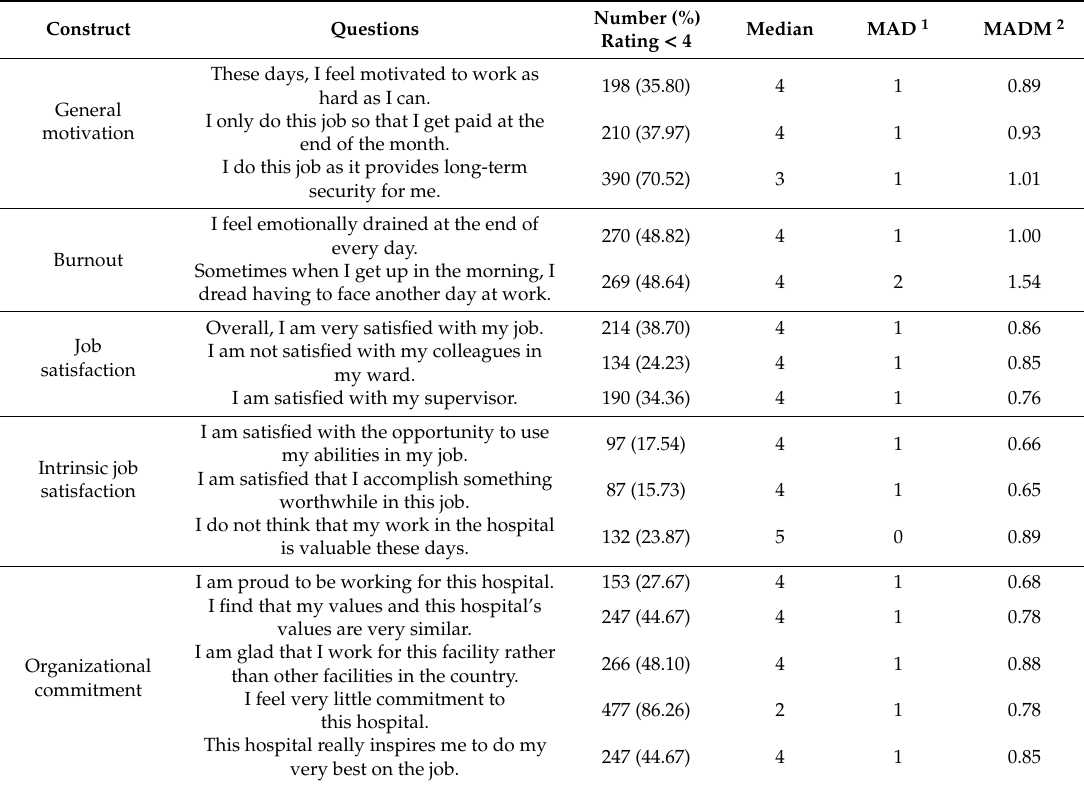
Table 4. The median and mean absolute deviation from the median for the motivation questions ( N =